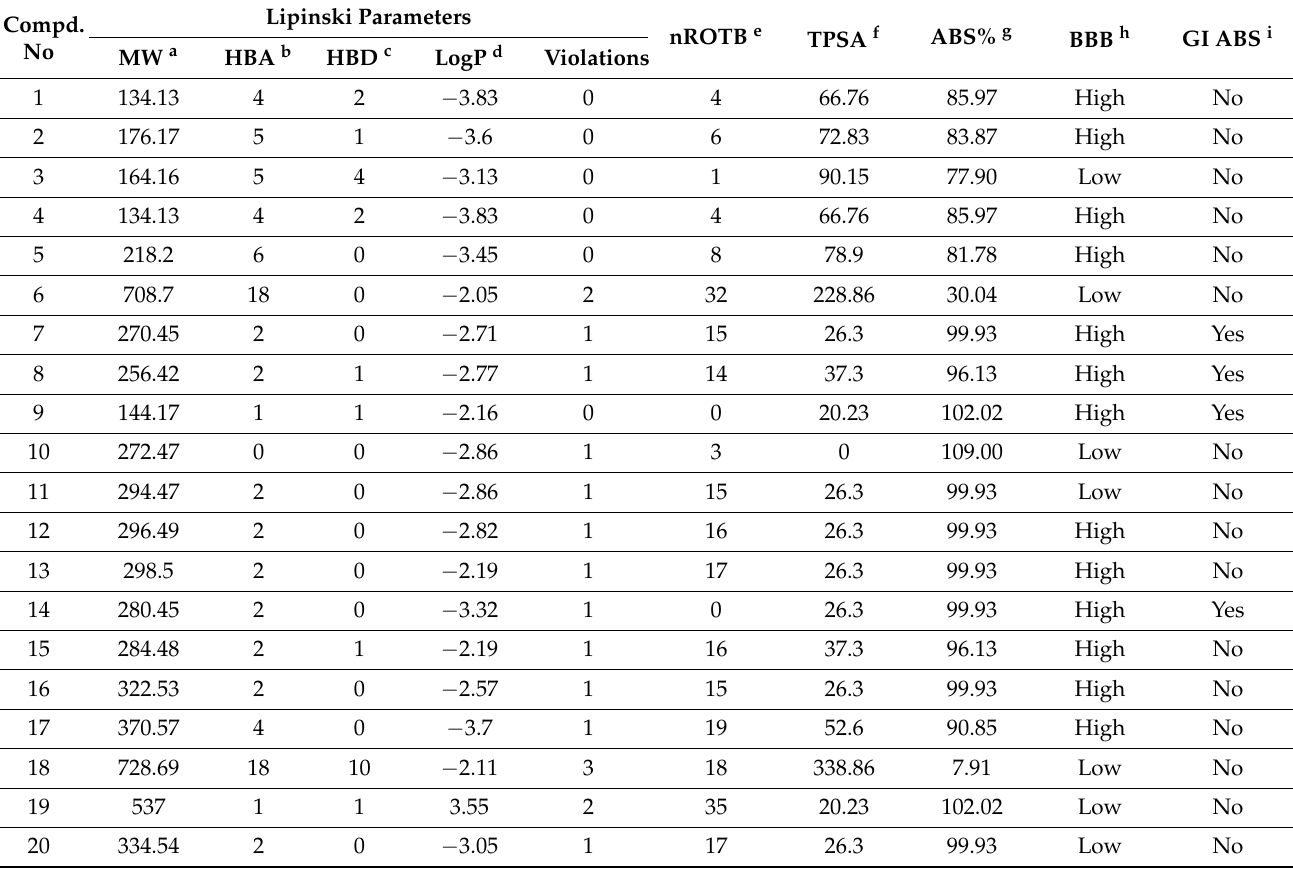
Table 7. Pharmacokinetics of target compounds’ ADMET